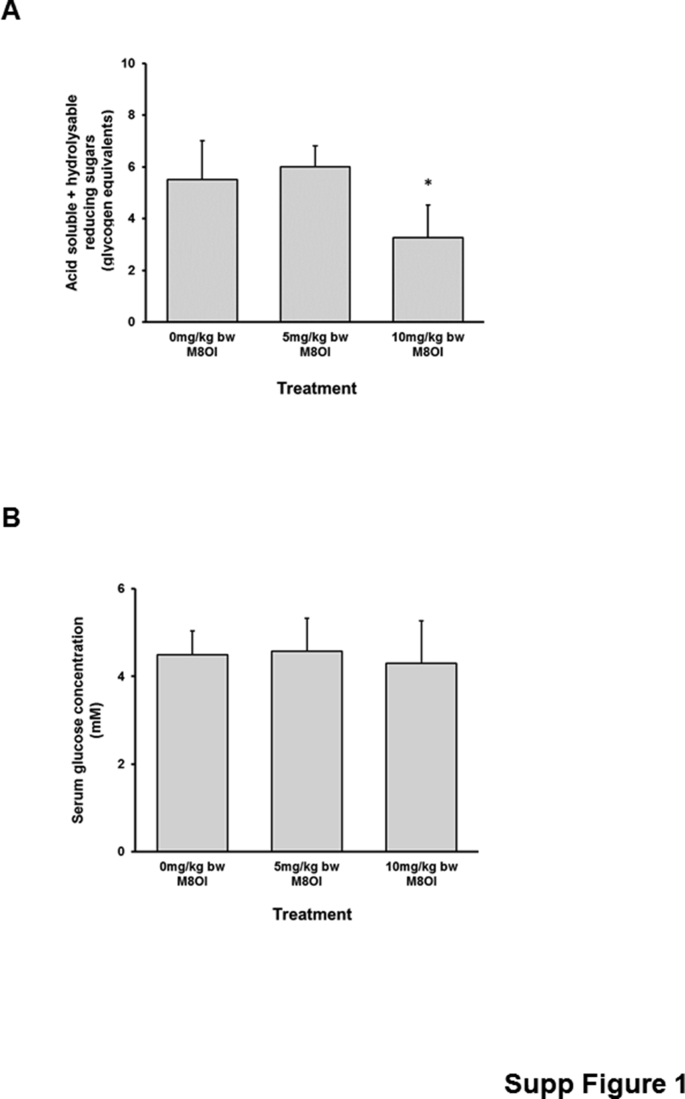
Effects of M8OI on hepatic acid-soluble and hydrolysable reducing sugars and serum glucose levels. A, acid-soluble and hydrolysable reducing sugars where determined and expressed relative to purified glycogen and normalised to total liver protein. B, serum glucose concentrations. All data are the mean and SD of at least 3 separate animals per group. *Significantly different (P > 0.95) from control using one way ANOVA followed by bonferroni post hoc test. .